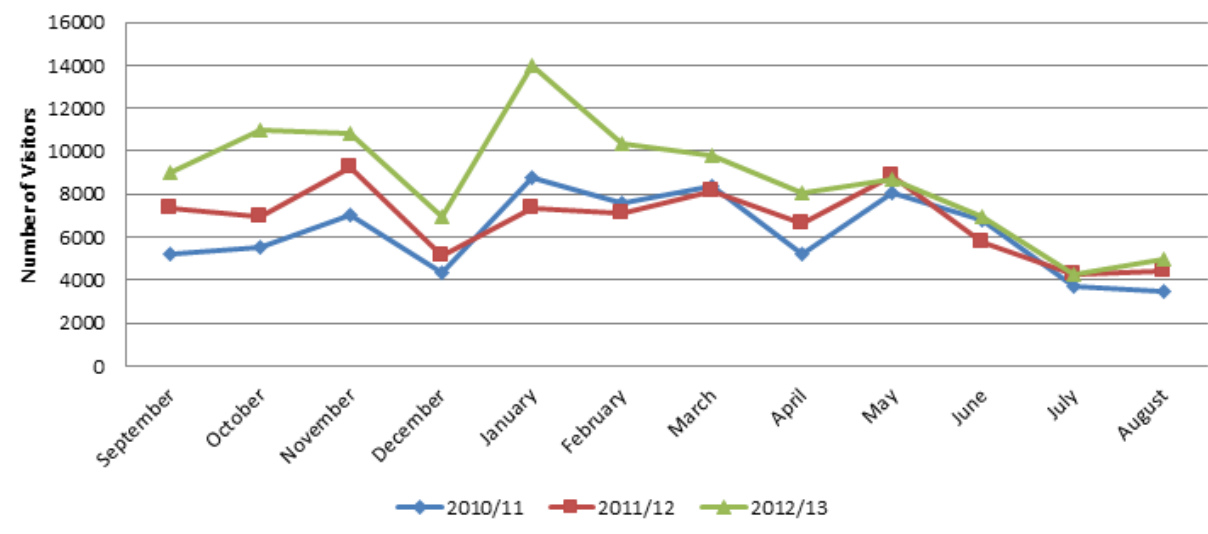
Figure 2. The number of visitors to the e-Bug website over each academic